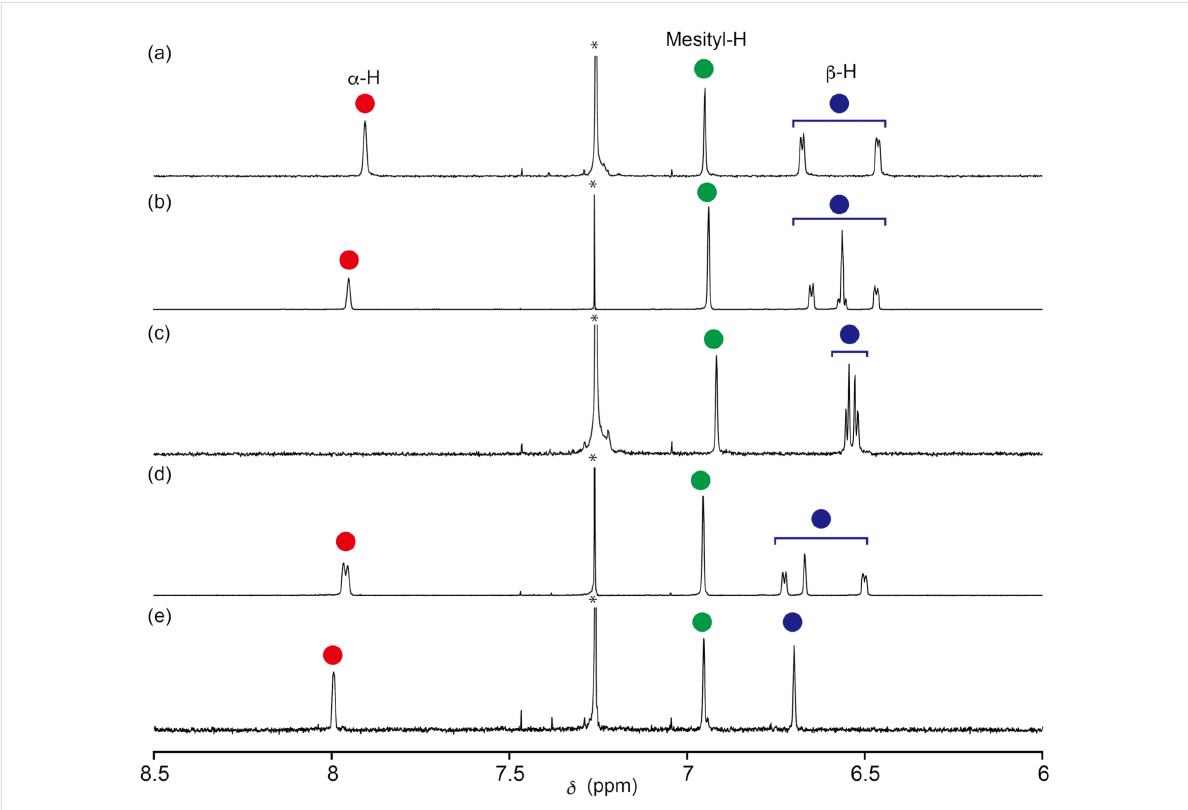
Figure 3: Partial 1 H NMR spectra of (a) 1a , (b) 3a , (c) 4a , (d) 5a , and (e) 6a recorded in CDCl 3 at 298 K. Asterisks indicate the residual solvent